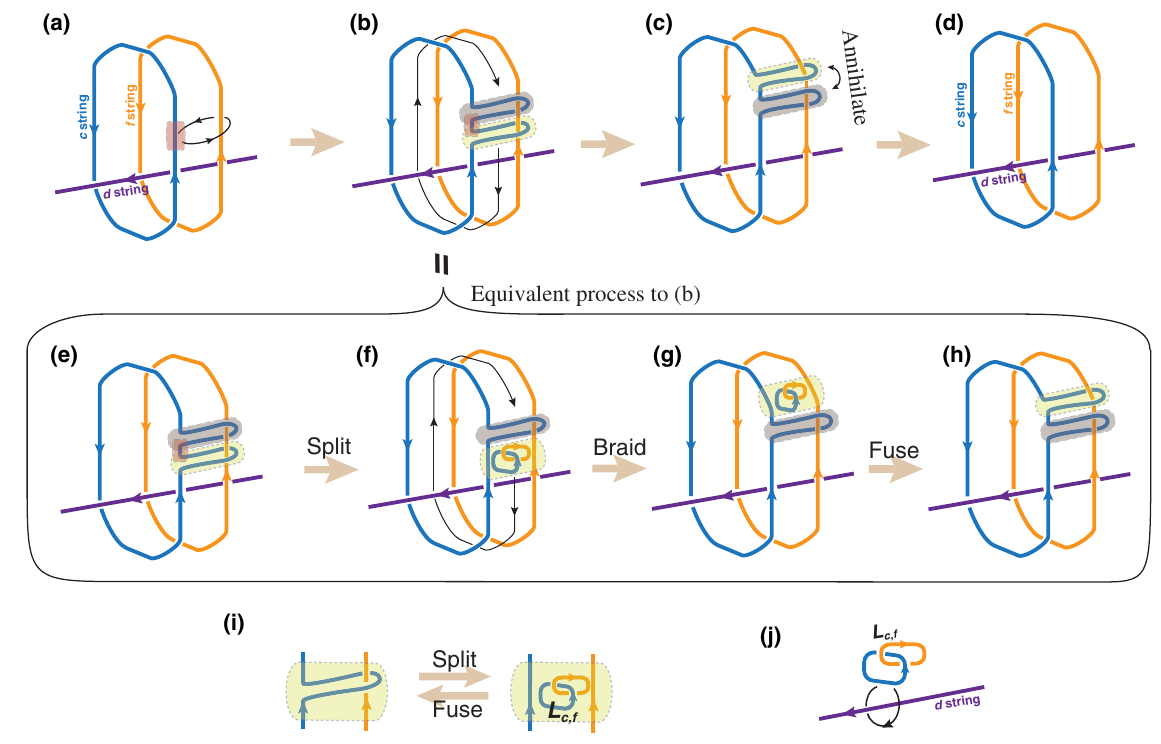
FIG. 12. (a) – (d) An alternative string braiding process that is topologically equivalent to that shown in Fig. 10. Upon fusion and splitting of the strings, the process in (b) can be deformed to the combined process shown in (e) – (h). (i) The local identification of string configuration under splitting and fusion, which plays a central role in the reinterpretation of the process shown in (b). The total Berry ’ s phase in the string braiding process equals the Berry ’ s phase in the process induced by the braiding of the link L around the d string, as c;f is shown in (j). toward the − z direction, we essentially have to rotate the part of the link enclosed by the dashed gray line in Fig. 13(b) by π about the z axis. The net Berry ’ s phase associated with this rotation is equivalent to a full braid between c 2 and f 2 in a single layer and is, therefore,